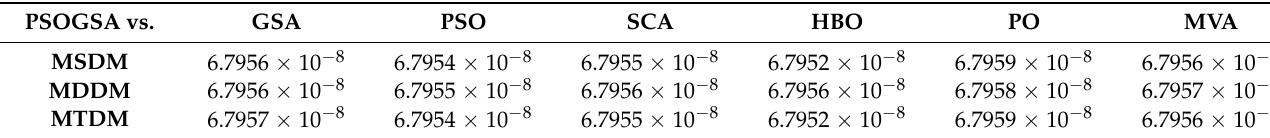
Table 18. Wilcoxon’s rank sum test for Case 2.